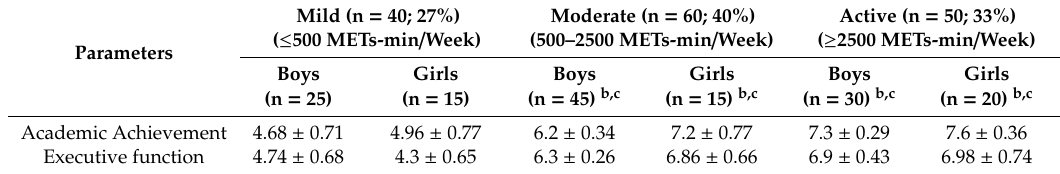
Table 3. Associations of academic achievement and executive function with gender and physical activity among participants (n =